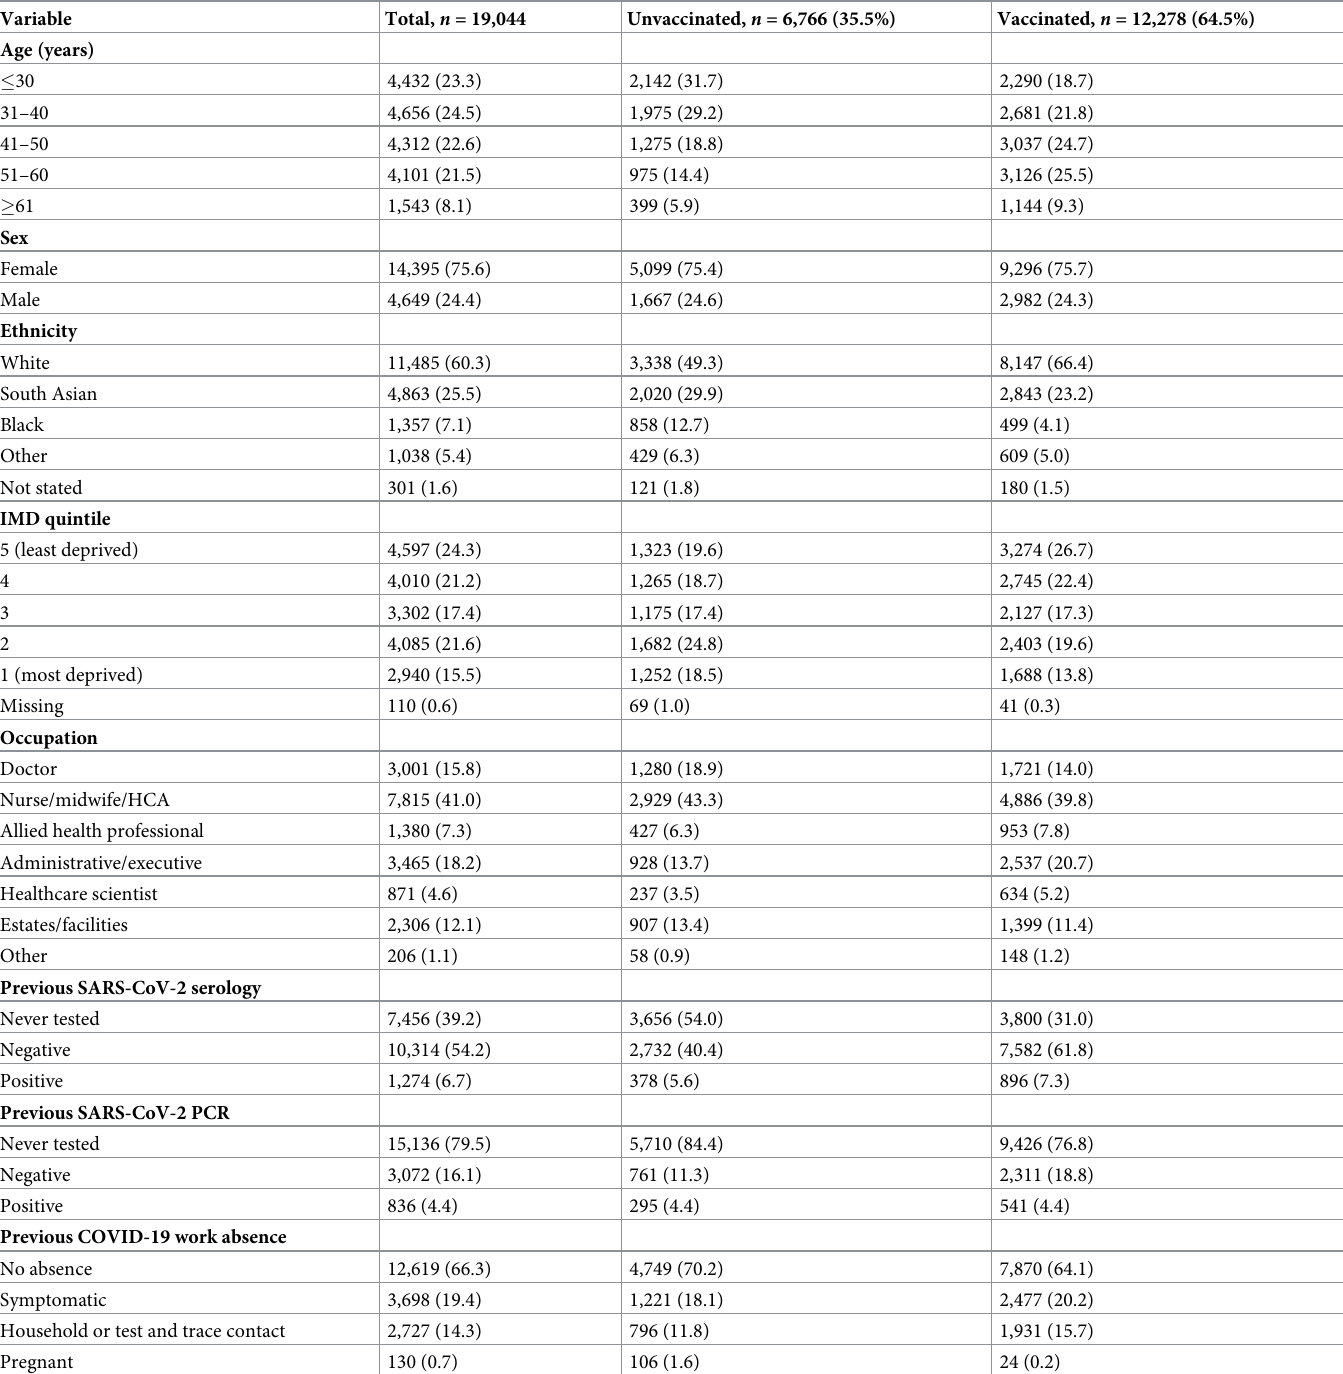
Table 1. Description of the cohort by vaccination